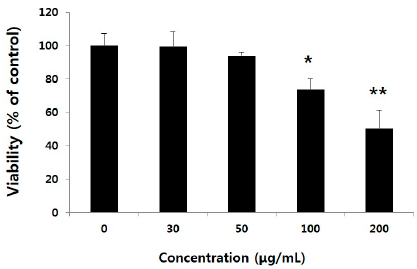
Figure 1. Effect of water extract of Gleditsia sinensis thorns (WEGST) on PC3 cell viability. PC3 cells were treated with various concentrations of WEGST (0–200 µg/mL) for 24 h. Cell viability was measured using the WST-1 assay kit. Each value is expressed as the mean ± standard deviation (SD) of three wells. Asterisks (*) refers to statistical differences compared to the control (non-treated). * p < 0.05 and ** p < 0.001.